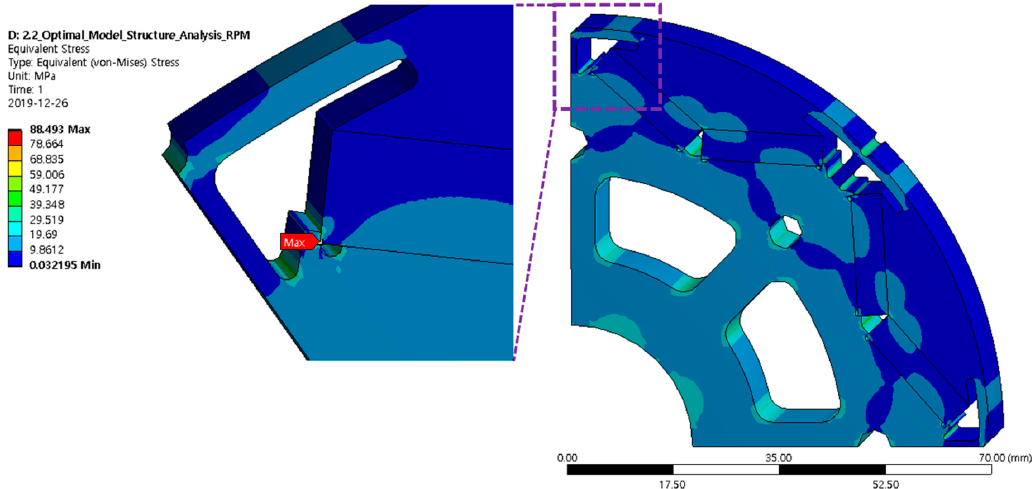
Figure 12. Mechanical stress generated in the rotor of the optimal model.